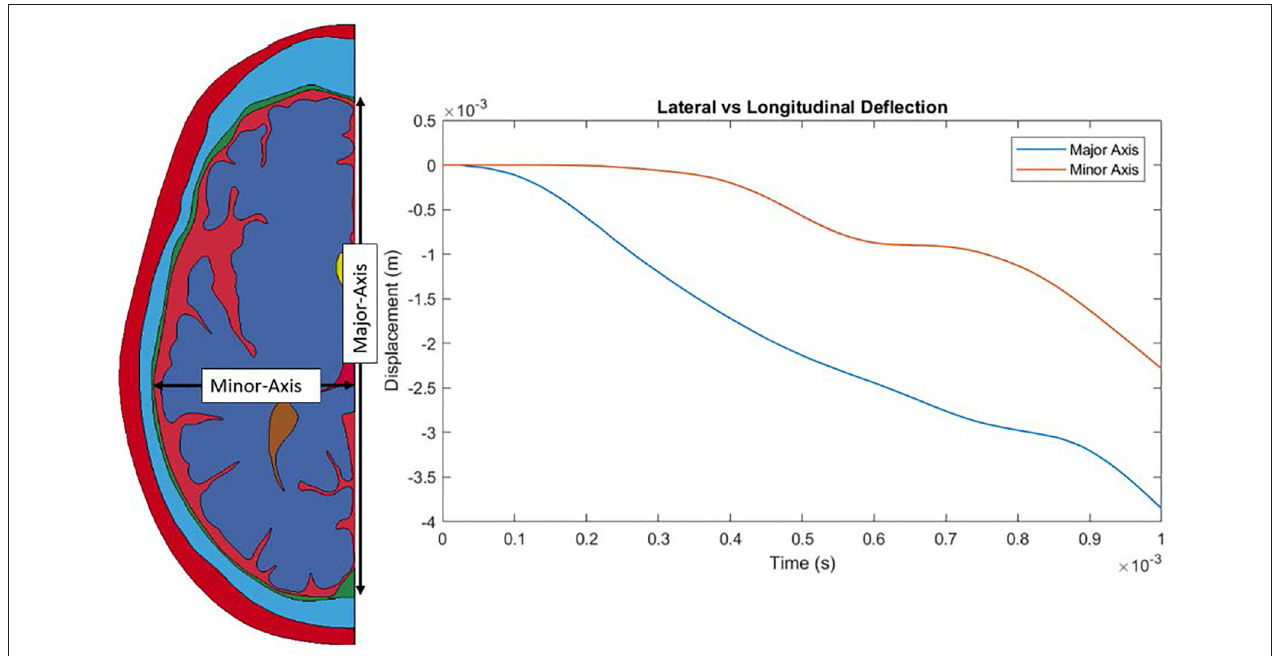
FIGURE 5 | Lateral and longitudinal skull flexure throughout the simulated impact.